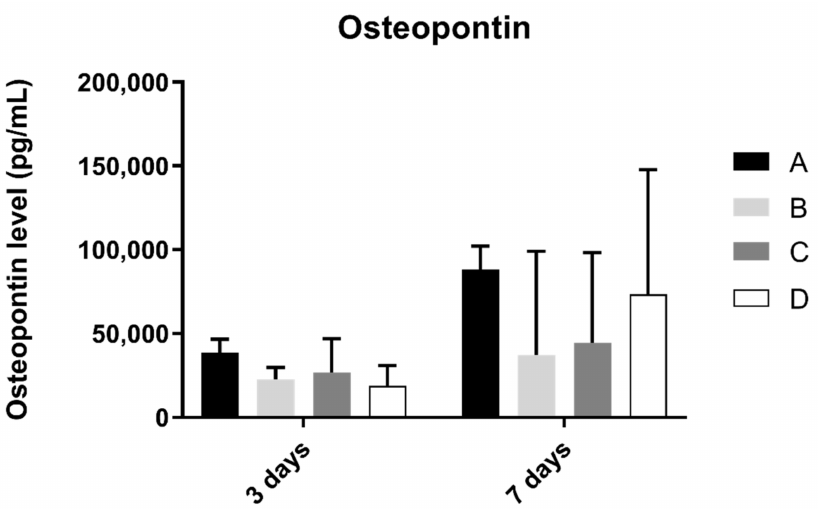
Figure 7. Osteopontin concentration (in pg/mL) obtained in osteoblast culture at 3 and 7 days of cell culture (N = 4), presented as mean and standard deviation (error bars), for each study group (as described in Table 1). A Kruskal–Wallis test, followed by Dunn’s post-hoc tests, was used for comparison between study groups. Statistical significance: p < 0.05.